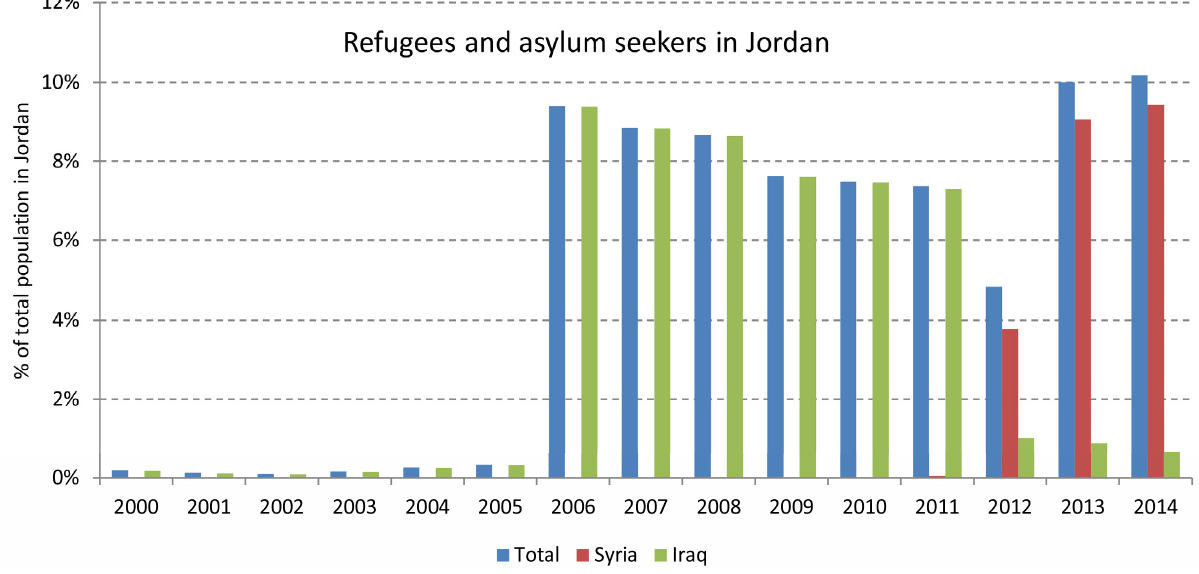
Figure 2. Refugees and asylum seekers in Jordan. Data: total population from [35]; refugee and asylum seekers population from